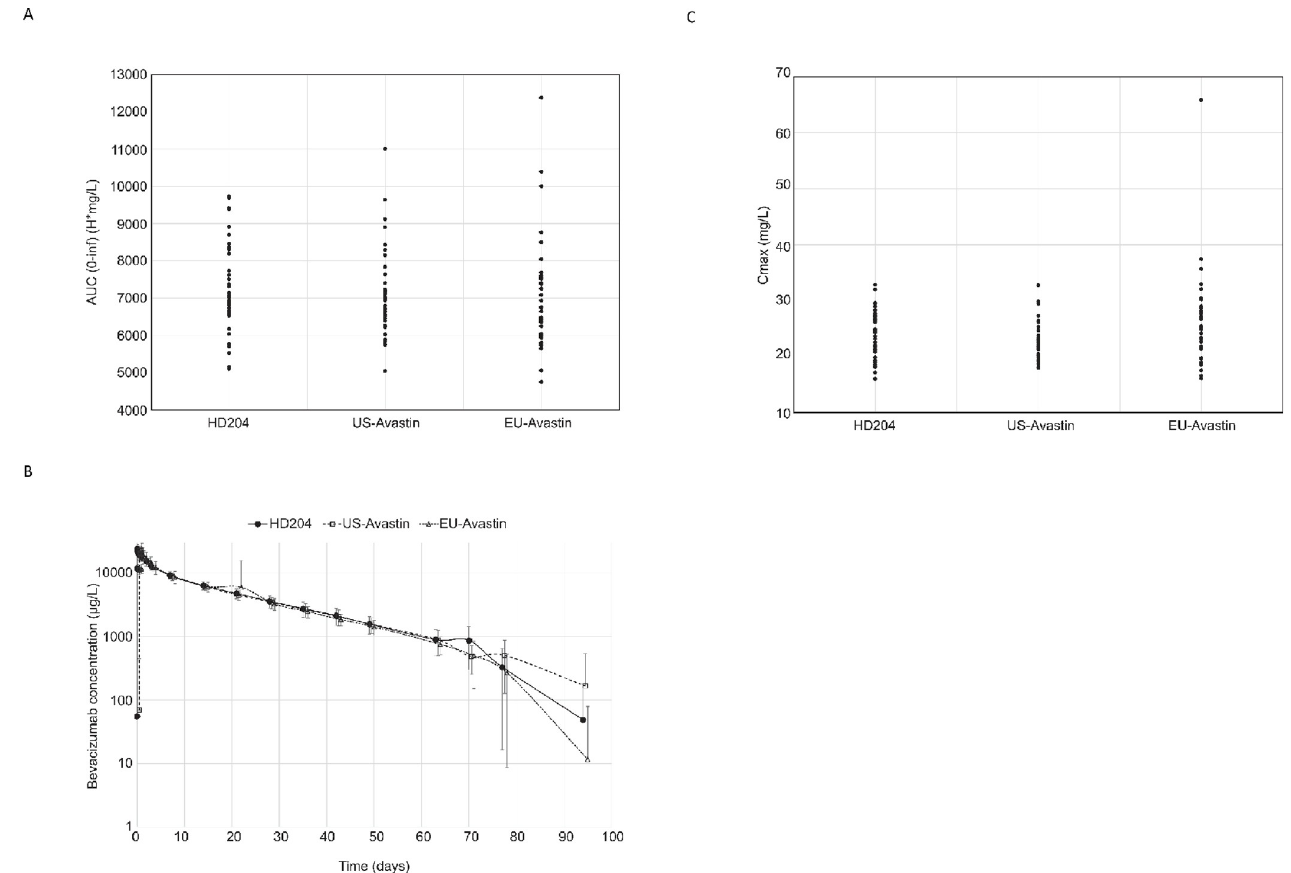
primary PK parameter AUC for HD204 versus US-sourced bevacizumab was 102.95, with 0-inf 90% CI [96.52% to 109.80%]. Since the 90% CI of the ratio of geometric means of AUC is 0-inf contained within the acceptance range [80% to 125%], the equivalence of HD204 with EU- sourced and US-sourced bevacizumab can be concluded. The ratio of the geometric mean of AUC for EU-sourced versus US-sourced bevacizu- 0-inf mab was 99.06, with 90% CI [92.92% to 105.61%]. Additionally, the 90% CI of the ratio of geometric means for the secondary PK parameters, AUC and C , of HD204 versus US-Avastin, HD204 versus EU-Avastin, and EU-Avastin 0-last max versus US-Avastin were all contained within the acceptance interval [80.00%; 125.00%] (Table 3). Therefore, based upon the secondary PK parameters, the pairwise equivalence of HD204, EU-sourced, and US-sourced bevacizumab can also be concluded. Safety Adverse events (AEs) regardless of causality were reported in 31 (77.5%) subjects of the HD204 group, 31 (77.5%) subjects of the US-sourced bevacizumab group, and 34 (87.2%) sub- jects of the EU-sourced bevacizumab group (Table 4). Treatment-related AEs (TEAEs) were reported for 10 (25.0%), 12 (30.0%), and 10 (25.6%) sub- jects in the HD204, US-sourced and EU-sourced bevacizumab groups, respectively. There were